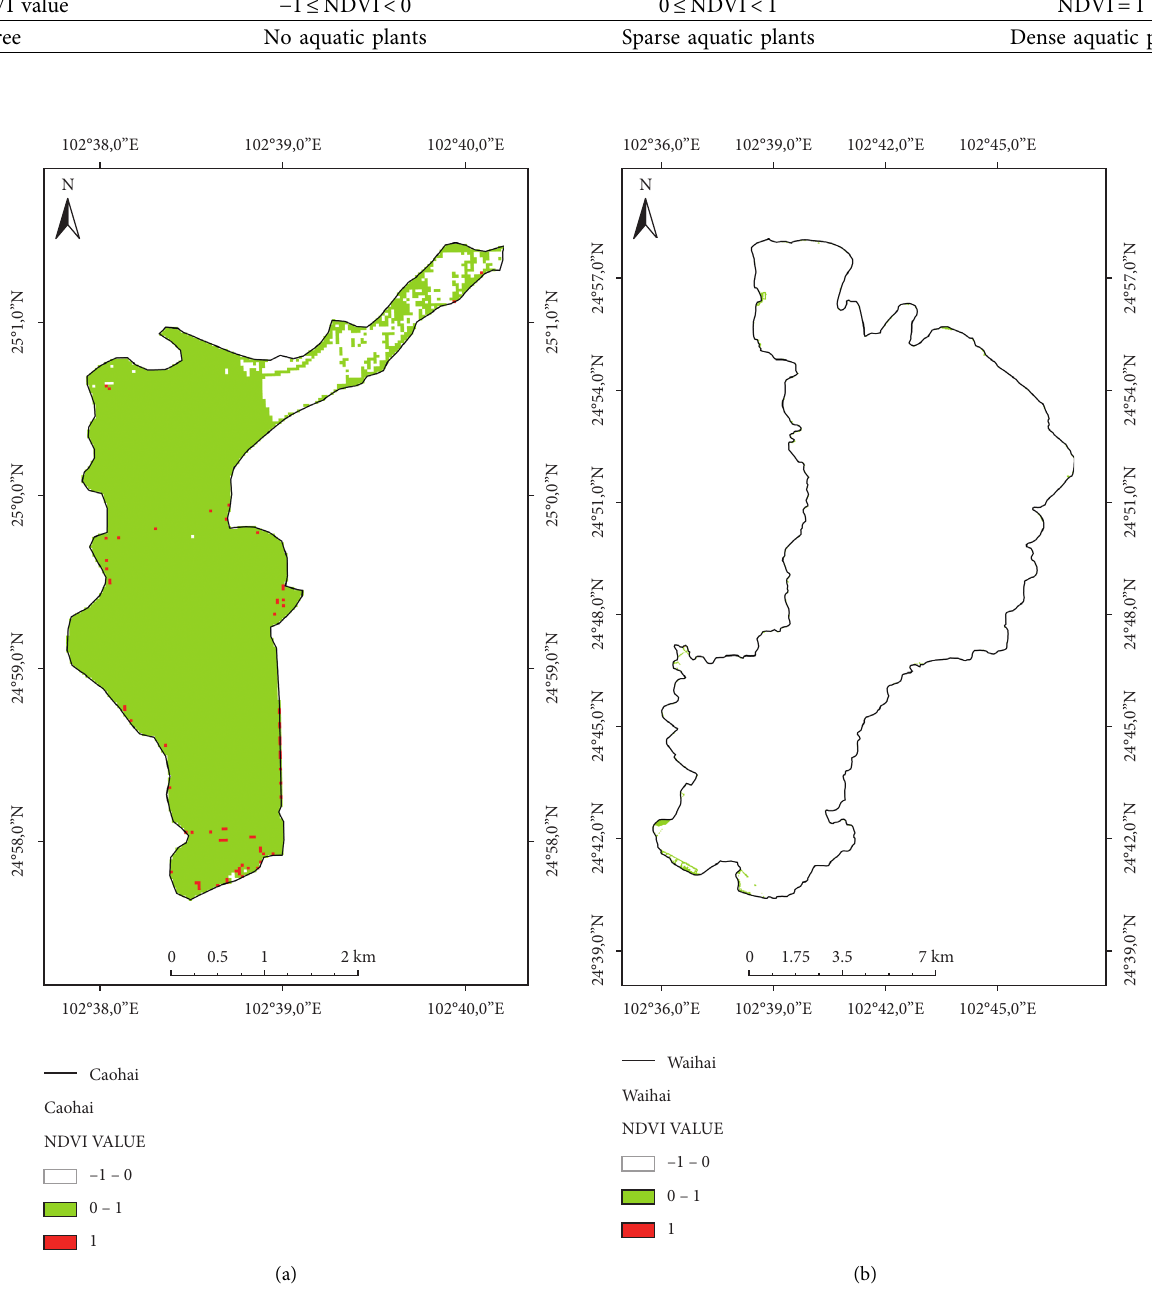
Figure 6: (a) Spatial distribution of water quality in Caohai based on NDVI value. (b) Spatial distribution of water quality in Waihai based on NDVI Table 7: The proportion of NDVI threshold in the study area.